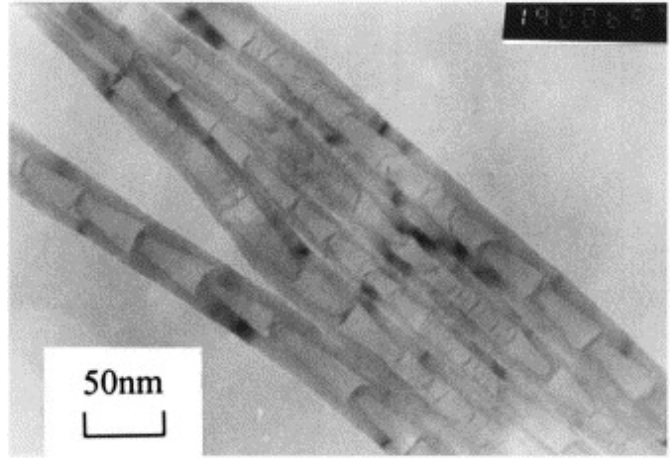
Figure 14. Typical bamboo-shaped carbon nanotubes from the CDM process under SEM [58].